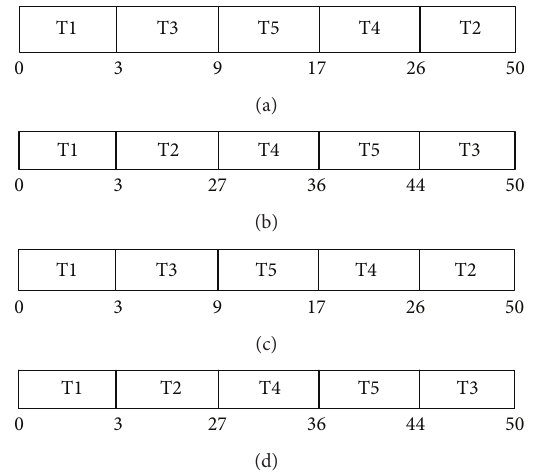
Figure 5: (a) Gantt chart for VOPS. (b) Gantt chart for PS. (c) Gantt chart for SJF. (d) Gantt chart for FS.